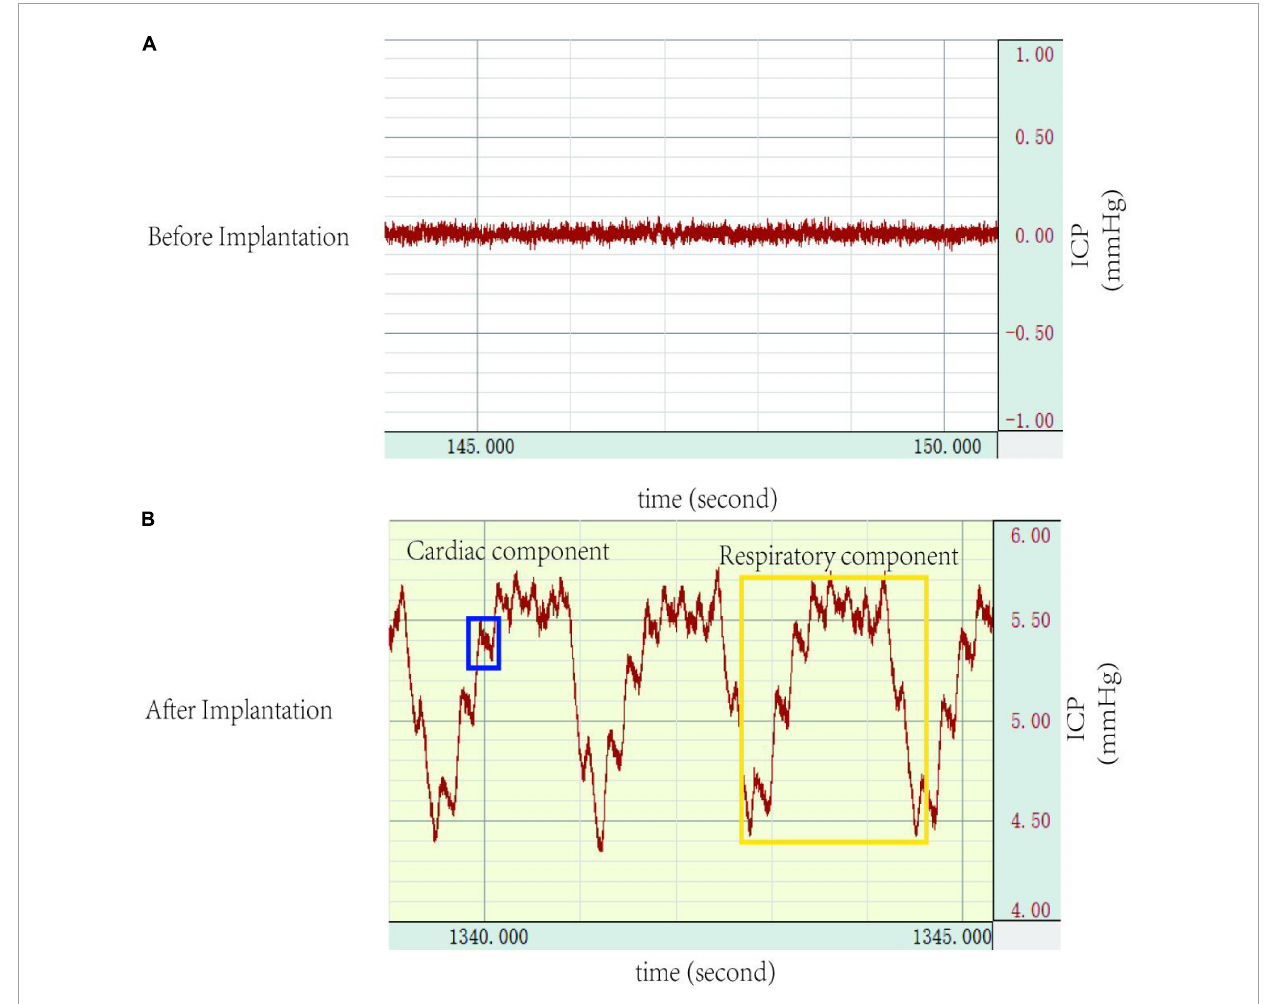
FIGURE4 Intracranial pressure (ICP) waveforms: (A) no waveforms were demonstrated before cannulation implantation into the cisterna magna, (B) a representative ICP trace after successful cannulation implantation into the cisterna magna detailing ICP waveforms, which shows a cardiac waveform (blue), and a respiratory waveform (yellow). ICP, intracranial